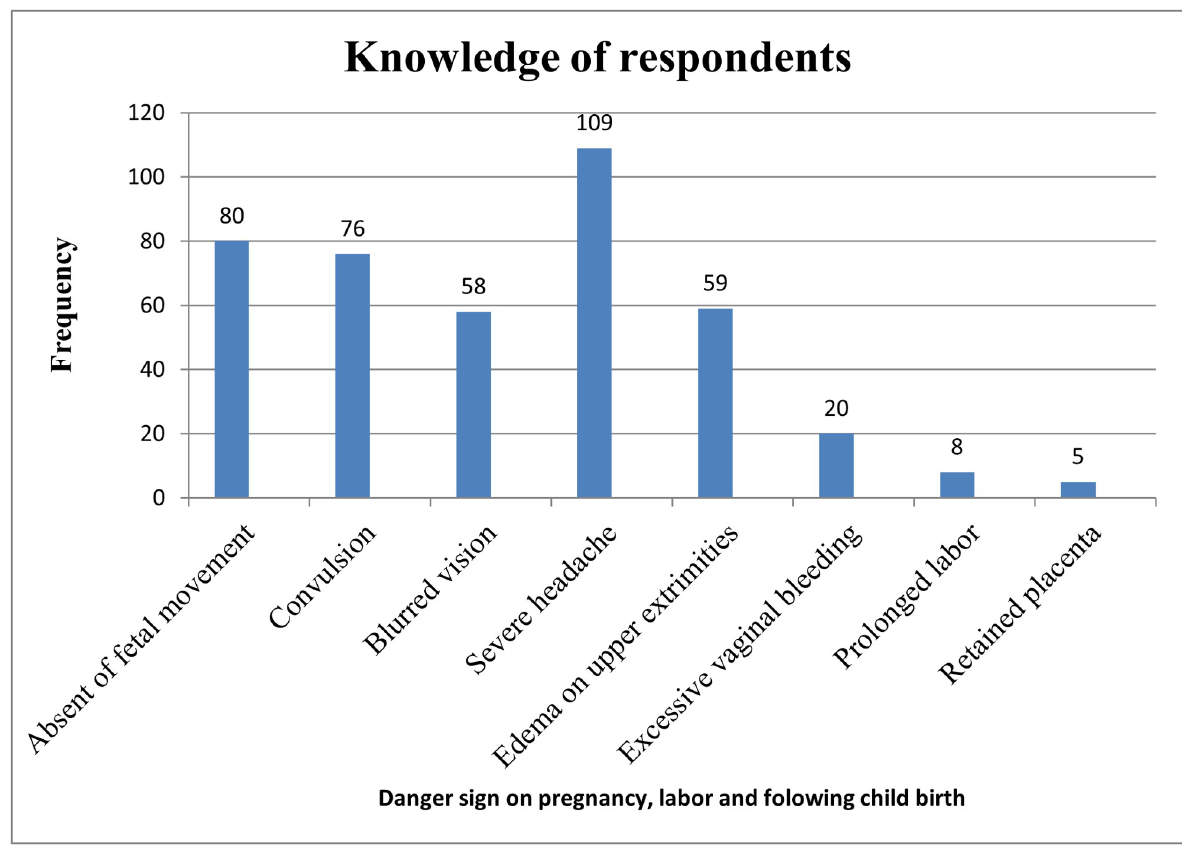
Fig 1. Distribution of knowledge on danger signs of pregnancy, labor, and following childbirth among pregnant women in Arba Minch health demographic surveillance site, 2021.